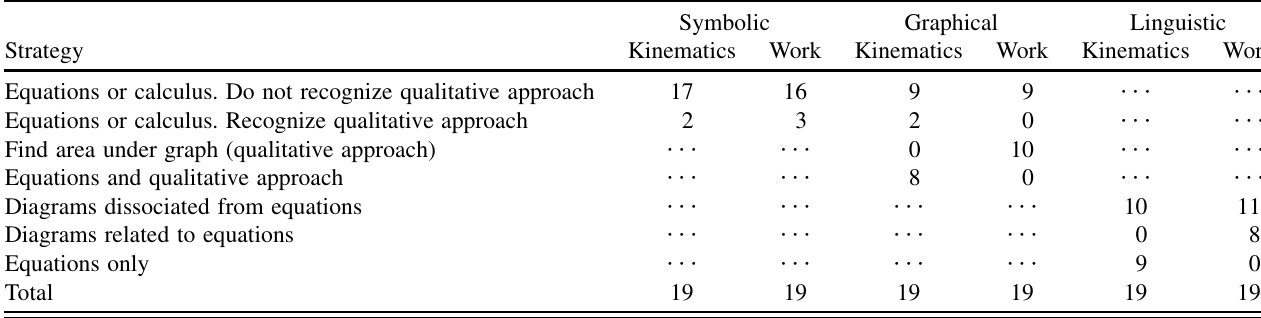
TABLE X. Strategy when handling tasks across the two topics requiring a quantitative solution.